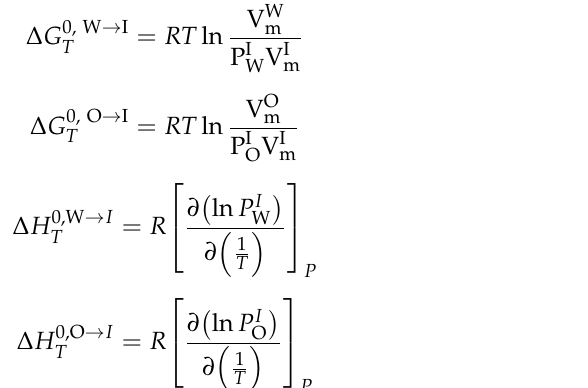
The enthalpy and entropy changes for the transfer of CA from the aqueous to the interfacial region, ∆ H 0,W → I and ∆ S 0,W → I , can be obtained from the variations of P WI at a T T series of temperatures by using the van ´ t Hoff Equation (12) and the Gibbs Equation (14), respectively. Similar equations are employed to determine ∆ H 0,O → I and ∆ S 0,O → I for the T T transfer of TOC. Figure 4 illustrates the variation of ln( P WI ) and ln( P OI ) with 1/ T according to the van ´ t Hoff equation, from where the enthalpy values of the transfer are obtained. An illustrative example of the determination of the thermodynamic parameters in emulsions is given in Figure 13 for caffeic acid and